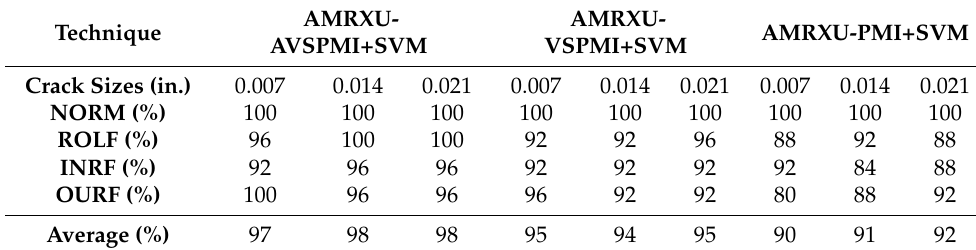
Table 6. The accuracy in state identification (torque load: 1 hp). Technique Crack Sizes